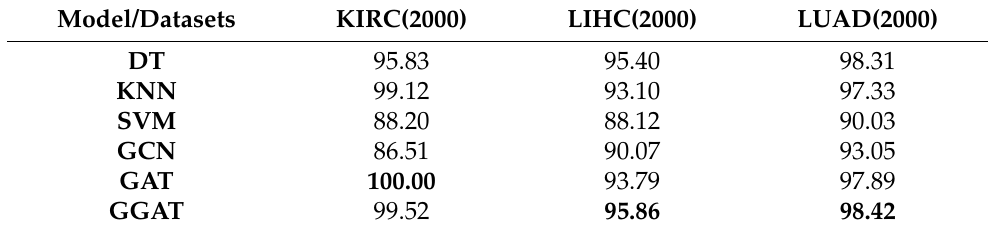
Table 14. Accuracy (%) of Models Under 2000 Feature